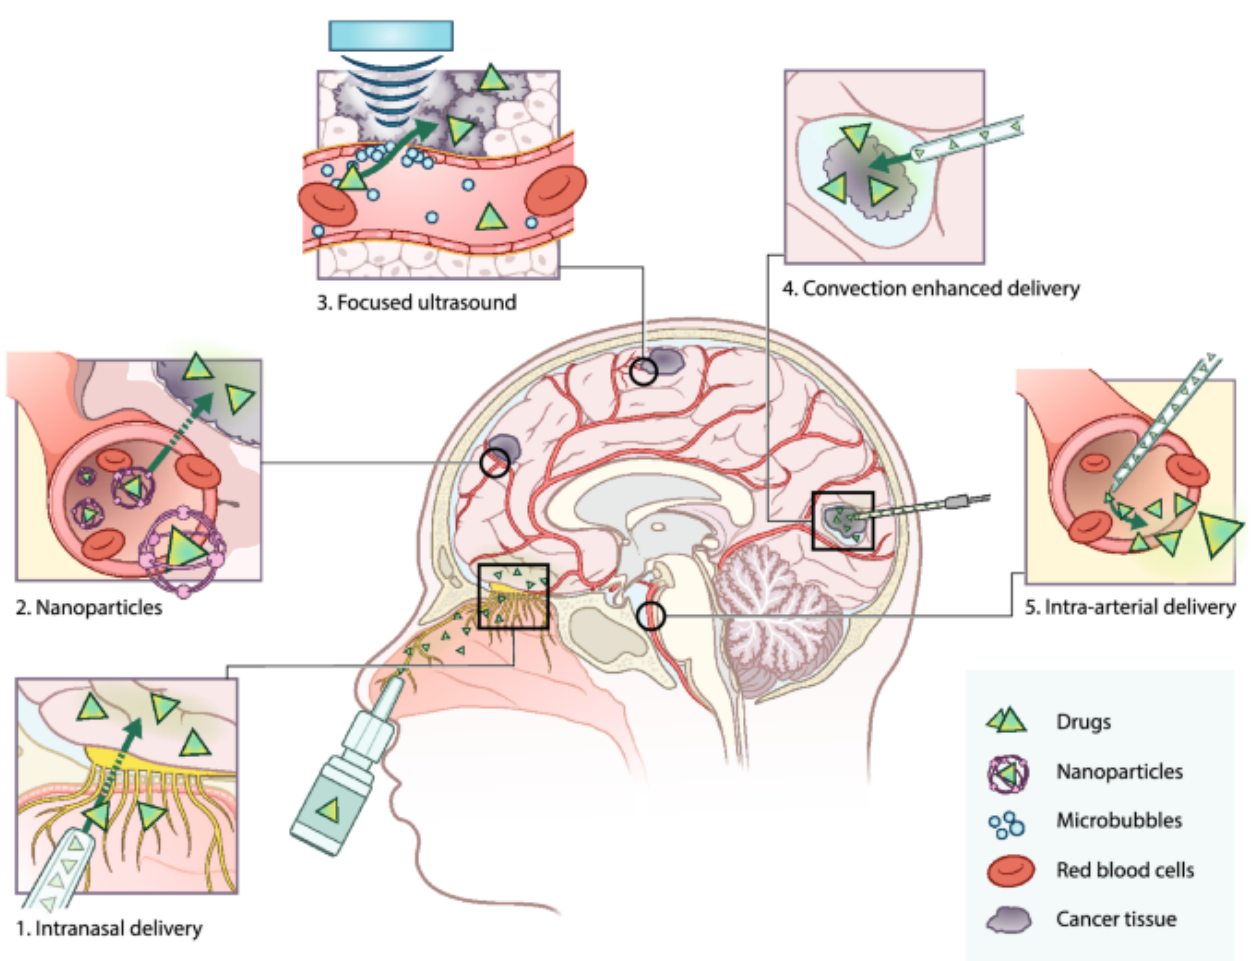
Figure 1. Overview of current drug delivery methods for the treatment of primary brain tumors. Panel 2—nanoparticles: nanoparticles encapsulate drugs to increase plasma half-life and allow entry to the brain parenchyma by the enhanced permeability and retention (EPR) effect, endocytosis, and receptor-mediated transcytosis. Panel 3—microbubble-mediated focused ultrasound: microbubbles are intravenously administered and upon the application of focused ultrasound, microbubbles start to oscillate. The oscillation disrupts the BBB, temporarily opening it to allow drugs to enter the brain parenchyma. Panel 4—convection enhanced delivery (CED): surgical placement of catheters in the brain to administer the drug directly in the tumor site [172].